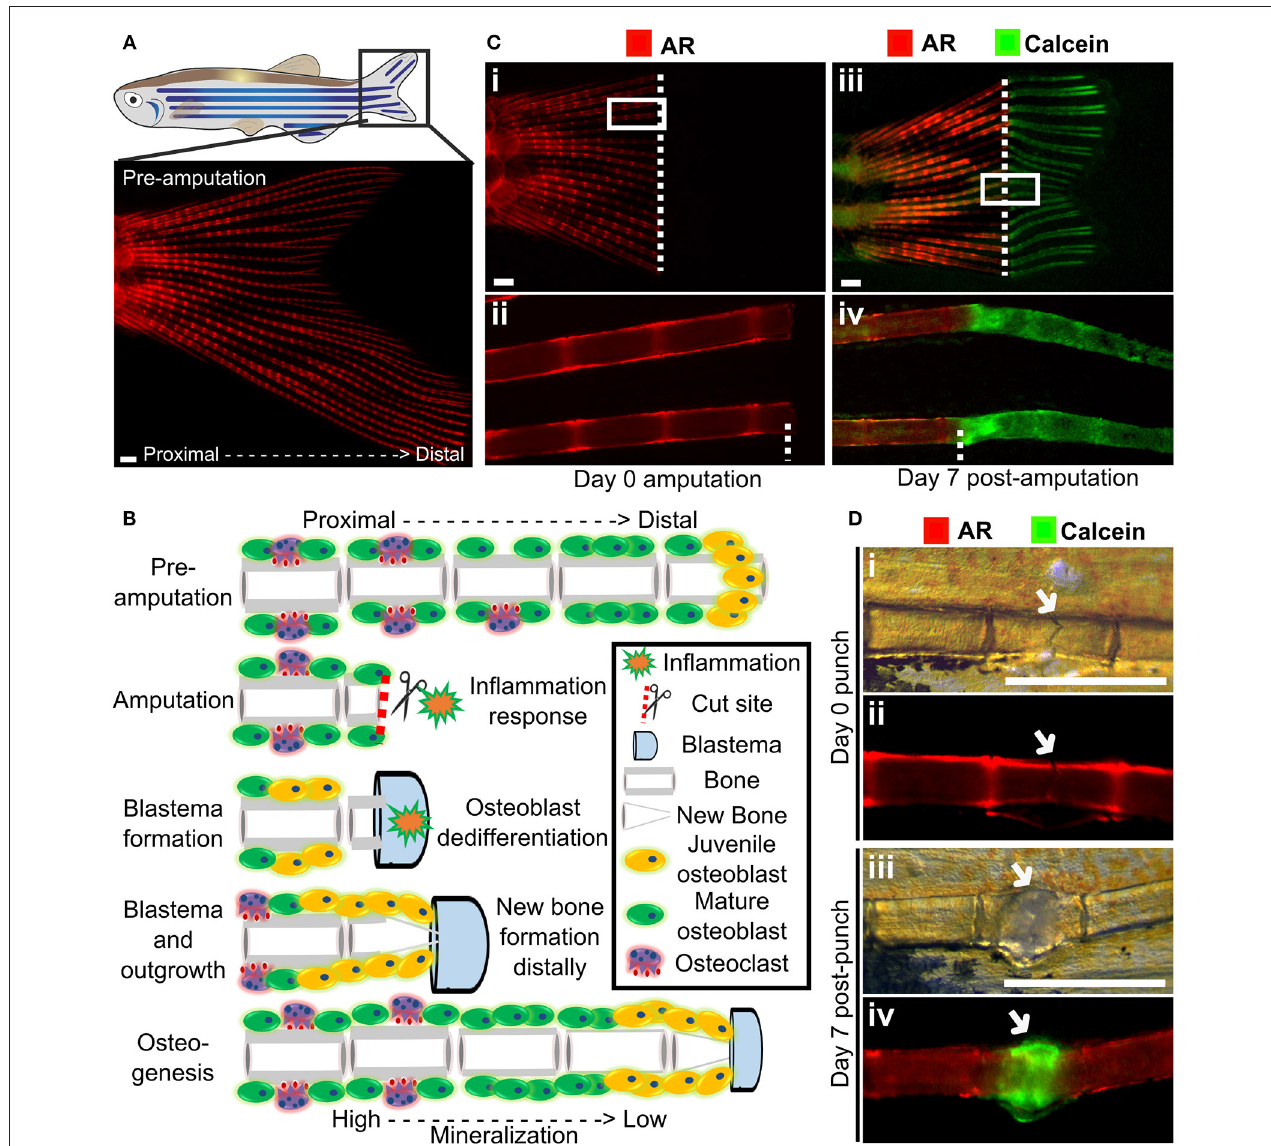
FIGURE 4 | Fin regeneration and fracture assay to visualize and quantify live bone formation and repair. (A) Schematic representation of a zebrafish with a standard fluorescent stereomicroscope image of a live Alizarin red S (AR) pre-amputation caudal fin (inset). (B) Schematic representation of bone regeneration after fin amputation showing the (simplified) cascade of events that follow after fin amputation to regenerate bone (a single ray depicted here). This allows studying de novo bone formation by newly formed osteoblasts (orange cells) and differentiated osteoblasts (green cells) and subsequent remodeling by osteoblasts and osteoclasts (purple cells) in an adult fish. Note that during osteogenesis that there is a gradient of mineralization. (C) Live images of the tail fin labeled with Alizarin red (red) prior to amputation (i, ii) and Calcein (green) post-amputation (iii, iv) taken on a fluorescent dissecting microscope. All images in panel come from the same fish. Seven days post-amputation showing regrowth of new bone (green). Note that intense Calcein staining is visible distally from the amputation site (white dotted line). (D) The fracture healing assay involves applying pressure on a fin ray bone element to induce a small fracture to one segment of the fin ray (i), which is visible with life AR staining (ii). Green Calcein labels the new bone formed in the fracture callus by 7 days (iii and iv). The white arrow indicates the fracture site. Scale bars = 500 µ m, 3 months old wildtype TL/EKK